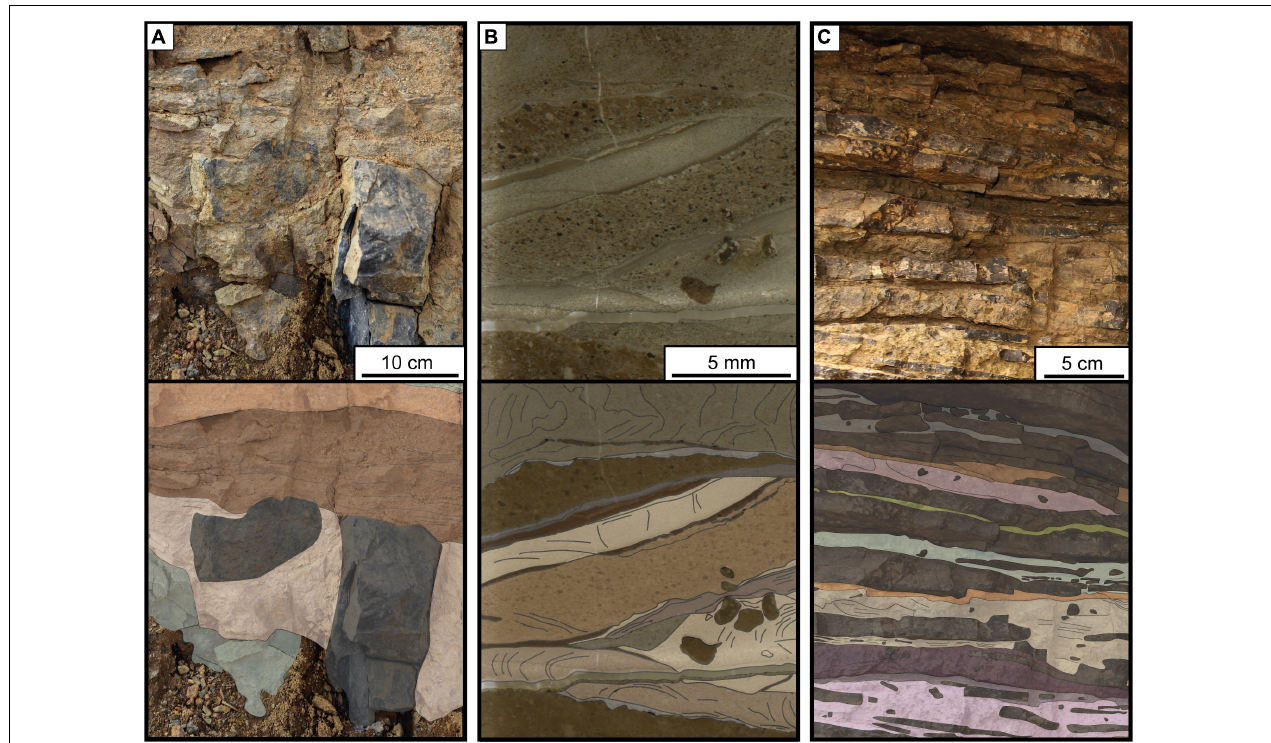
FIGURE 8 | Structures seen in the tuffisite fill with photographs (top) and interpretations (bottom). (A) A large block of ignimbrite stood on its end at the base of the tuffisite surrounded by massive sediment (Structure 1). (B) A thin section with particle-filled veinlets that have finely laminated material at their walls and a coarser massive centre (Structure 2). (C) Ribbons of tuffisite interfingered with ignimbrite sheets (Structure